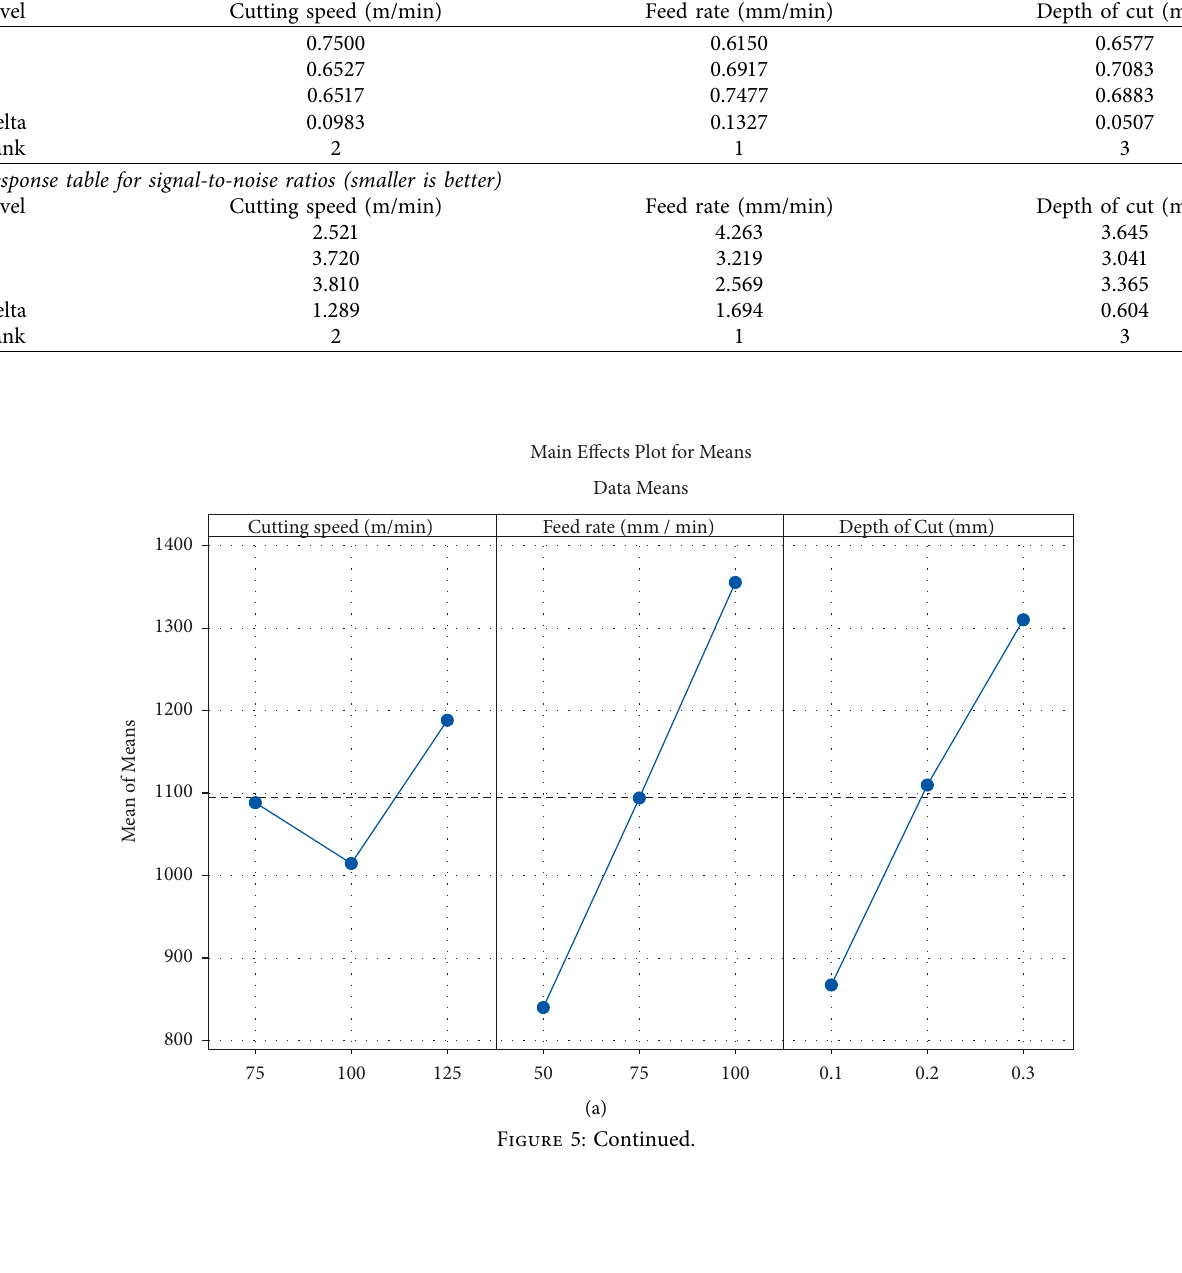
Table 5: Response mean table for SNR on surface roughness of the machined DMLS Inconel 718 alloy response table for means.